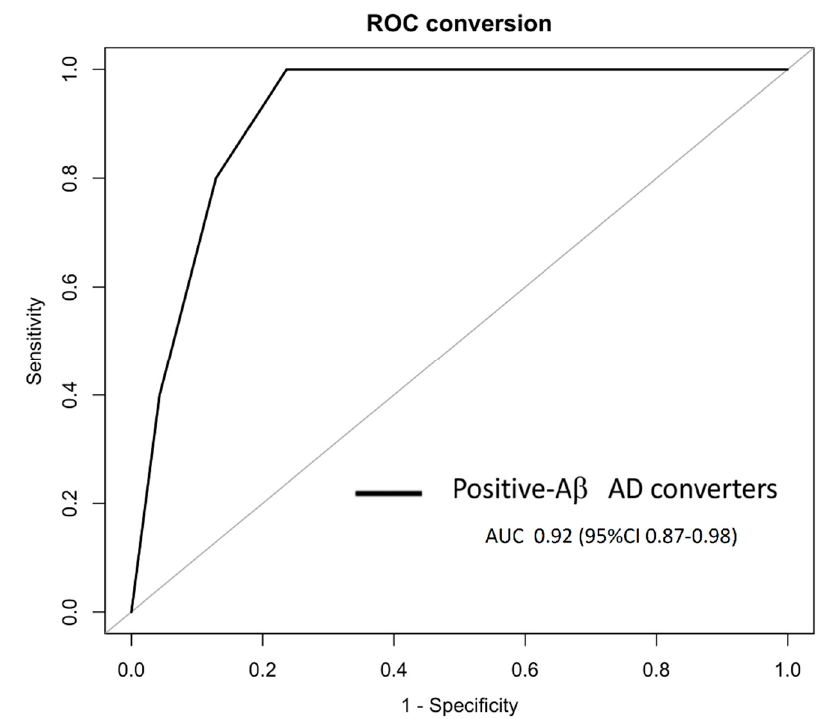
Figure 6. In PharmaCog/E-ADNI, the U-p53 2D3A8+ plasma-based algorithm was able to identify at least 6–30 months prior to A β -positive AD conversion. The ROC derived from the regression tree algorithm was obtained using the PharmaCog/E-ADNI subset and combining U-p53 2D3A8+ with MMSE and APOE ε 4 for classifying A β + -aMCI patients who will progress to AD after 6–30 months. A β + AD converters: AUC 0.92 (95% CI: 0.87–0.98).